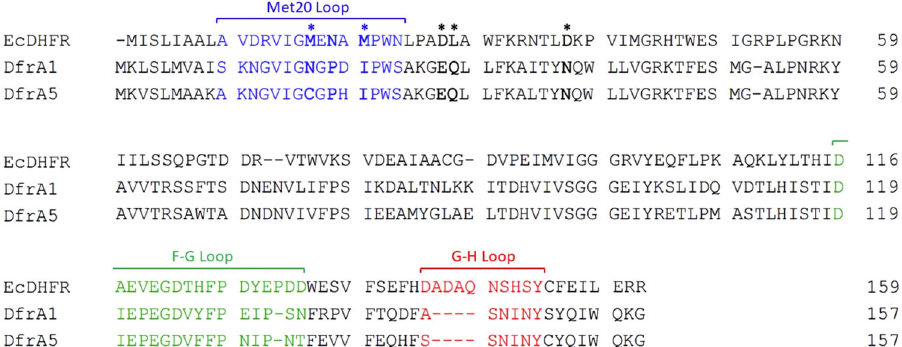
Fig. 1 Sequence alignment of E. coli DHFR (EcDHFR) with DfrA1 and DfrA5. Variations in the Met20 loop (blue), F-G loop (green), and G-H loop (red) are not only responsible for trimethoprim resistance, but also explain differences in steady-state kinetics. Notable active site variations (*) are directly involved in trimethoprim